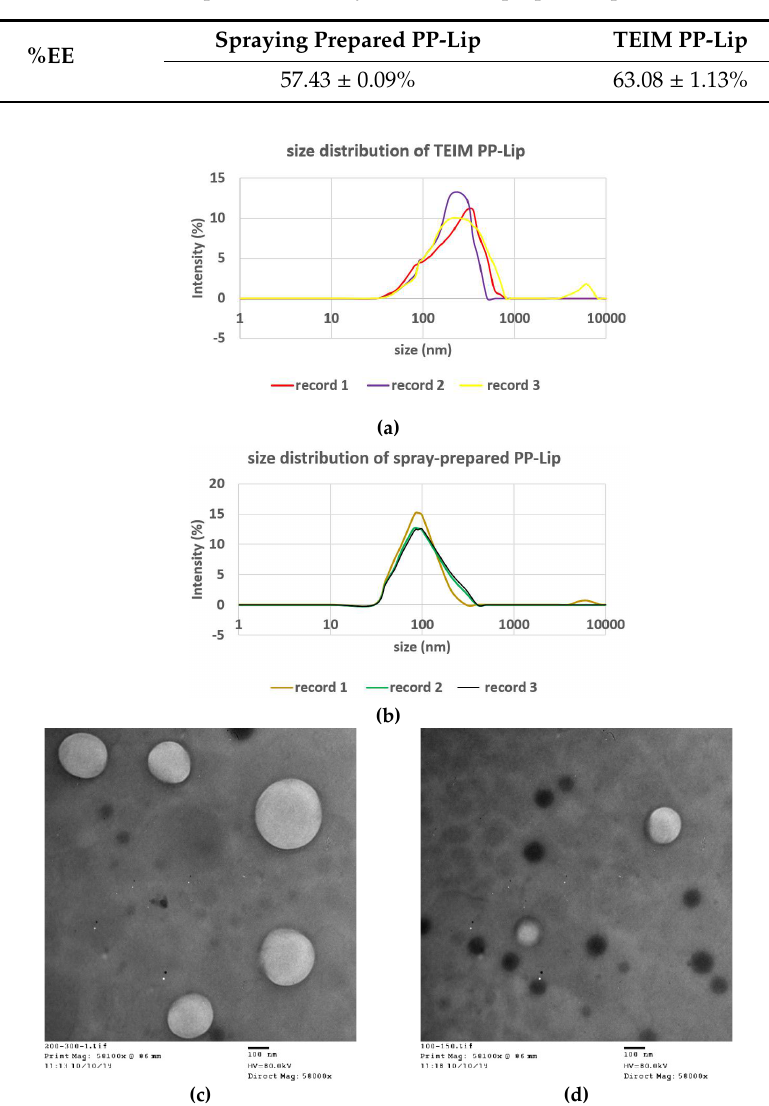
Figure 5. Top: particle size distribution of liposomes prepared using ( a ) TEIM and ( b ) spray method. Transmission electron microscope (EM) image of the ( c ) TEIM-prepared and ( d ) spray-prepared PP-Lip.